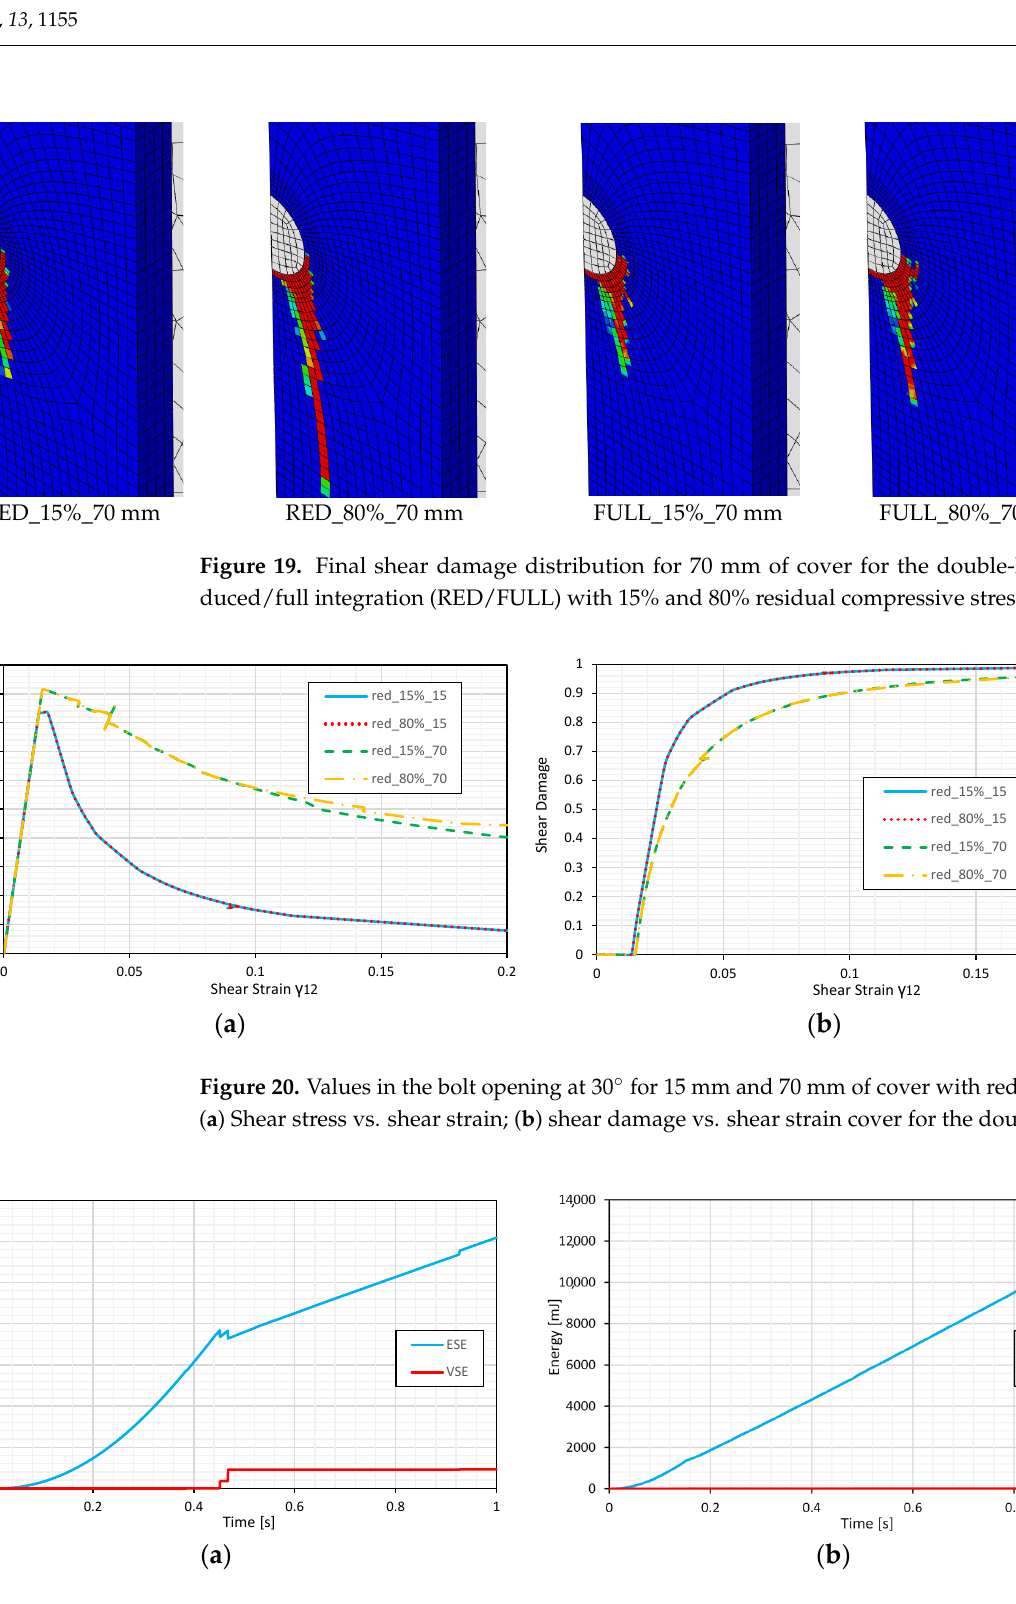
Figure 21. Total elastic and viscous damage energy for ( a ) reduced integration for 15 mm cover with 15% residual compressive stress; ( b ) reduced integration for 70 mm cover with 80% residual com-